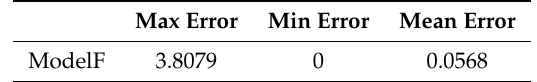
Table 1. The maximum, minimum, and mean of distance error value of